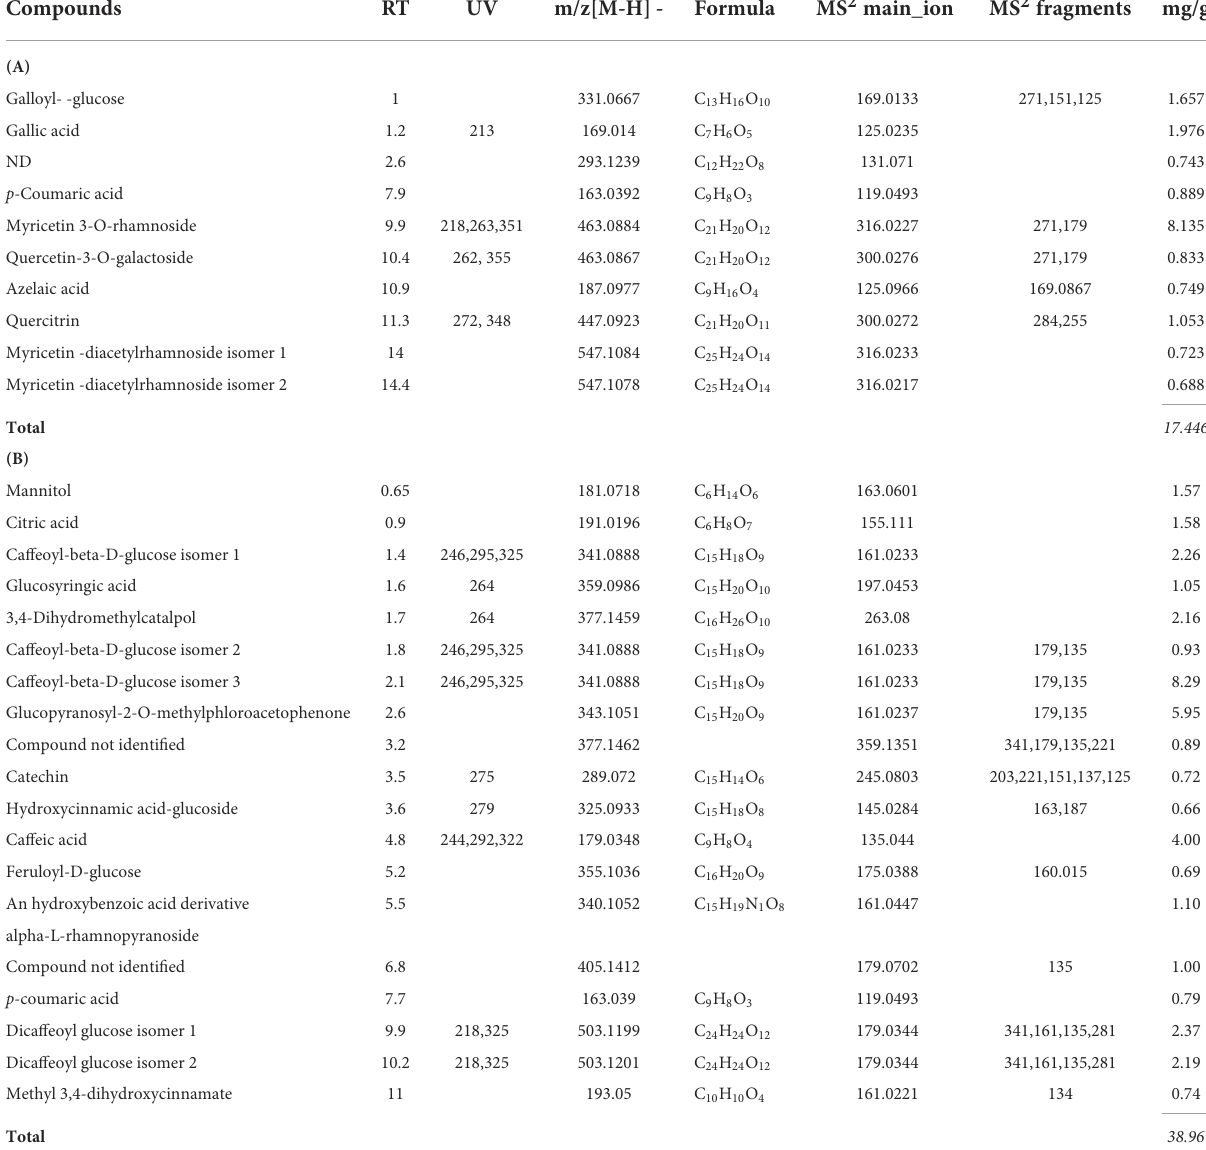
TABLE 5 LC-MS/MS analysis with tentative annotation of major phenolic compounds in P. maritimum after 30 days of acclimatization (A) and after 90 days of greenhouse cultivation (B).